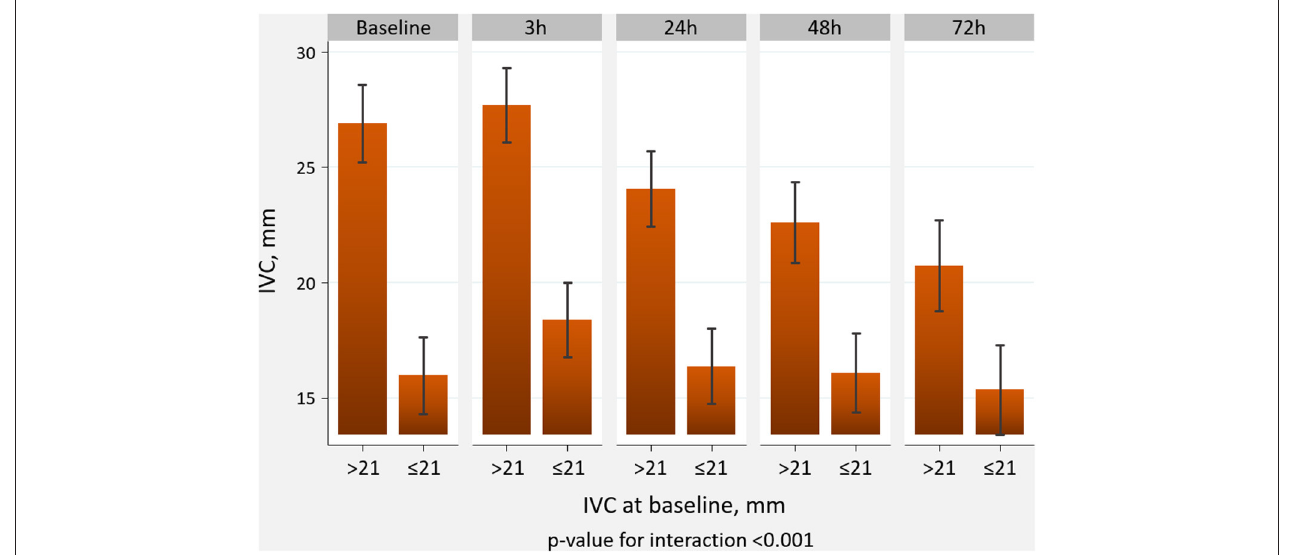
FIGURE 2 | Effect of venous compression on the trajectory of IVC diameter across IVC status at baseline. IVC, inferior vena cava.